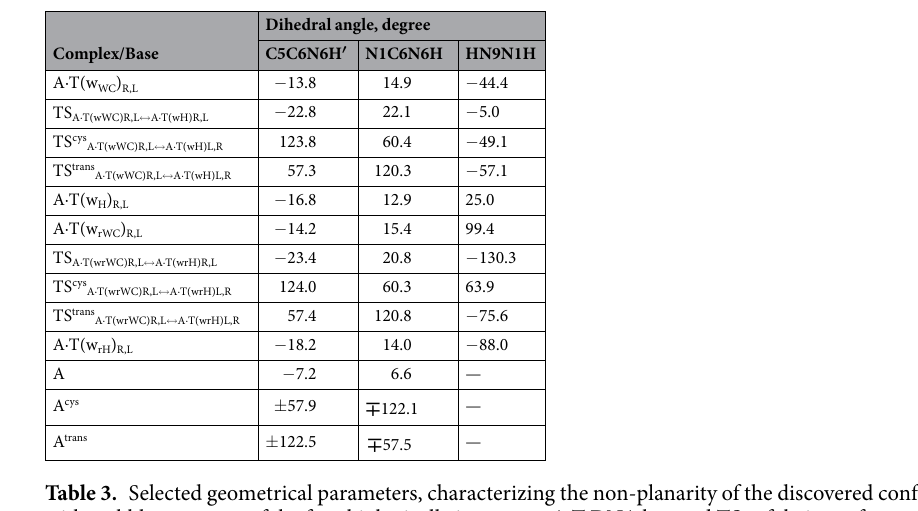
Table 3. Selected geometrical parameters, characterizing the non-planarity of the discovered conformers with wobble geometry of the four biologically important А·Т DNA bps and TSs of their conformational interconversions, obtained at the B3LYP/6-311 ++ G(d,p) level of theory in the continuum with ε = 4. Note: Signs of the dihedral angles are presented exclusively for one type of enantiomers.